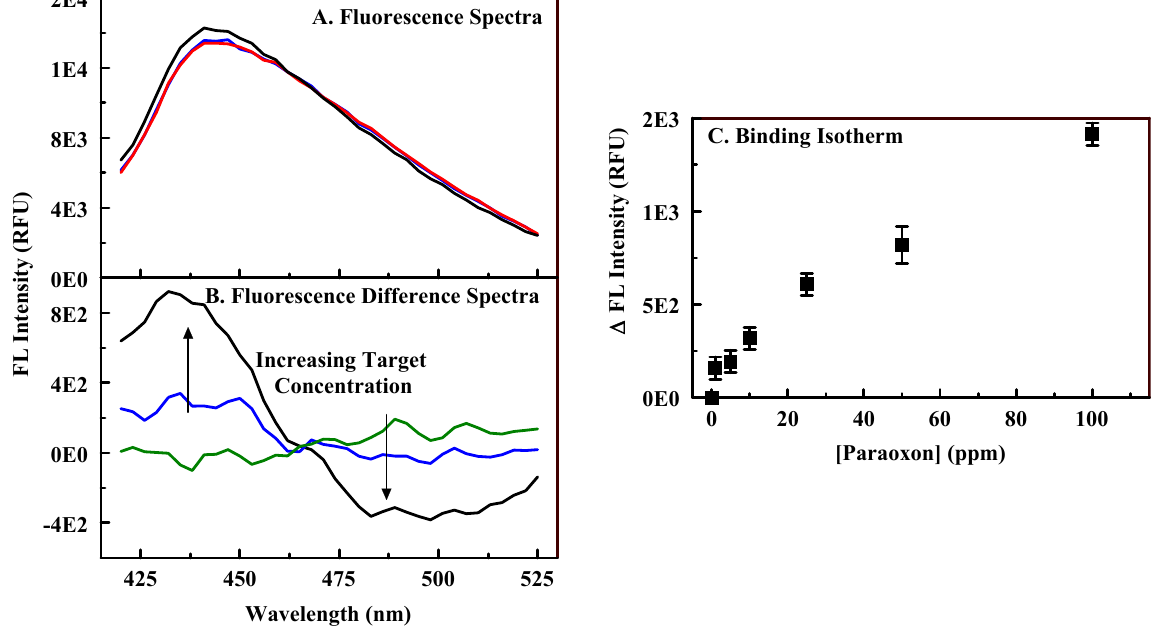
Figure 7. Interaction of paraoxon with Material 4 . Panel A, fluorescence excitation spectra for the Ni(II) C S TPP-embedded version of Material 4 in the presence/absence (red) of 1 3 5 ppm (blue) and 100 ppm (black) paraoxon. Panel B, difference fluorescence spectra for exposure of the material to 0.1 ppm (green), 10 ppm (blue), and 100 ppm (black). Panel C, binding isotherm for the interaction based on the peak/trough difference in intensity at 435 and 495